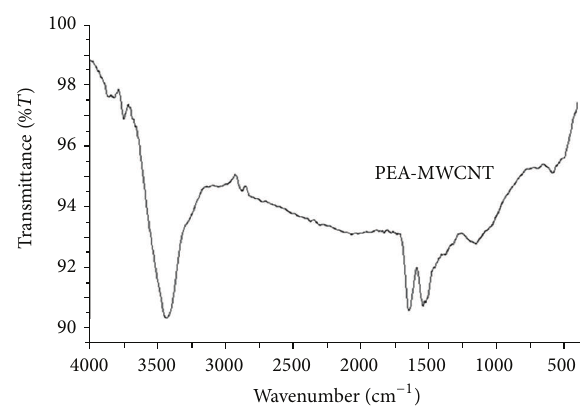
Figure 6: Raman spectra of